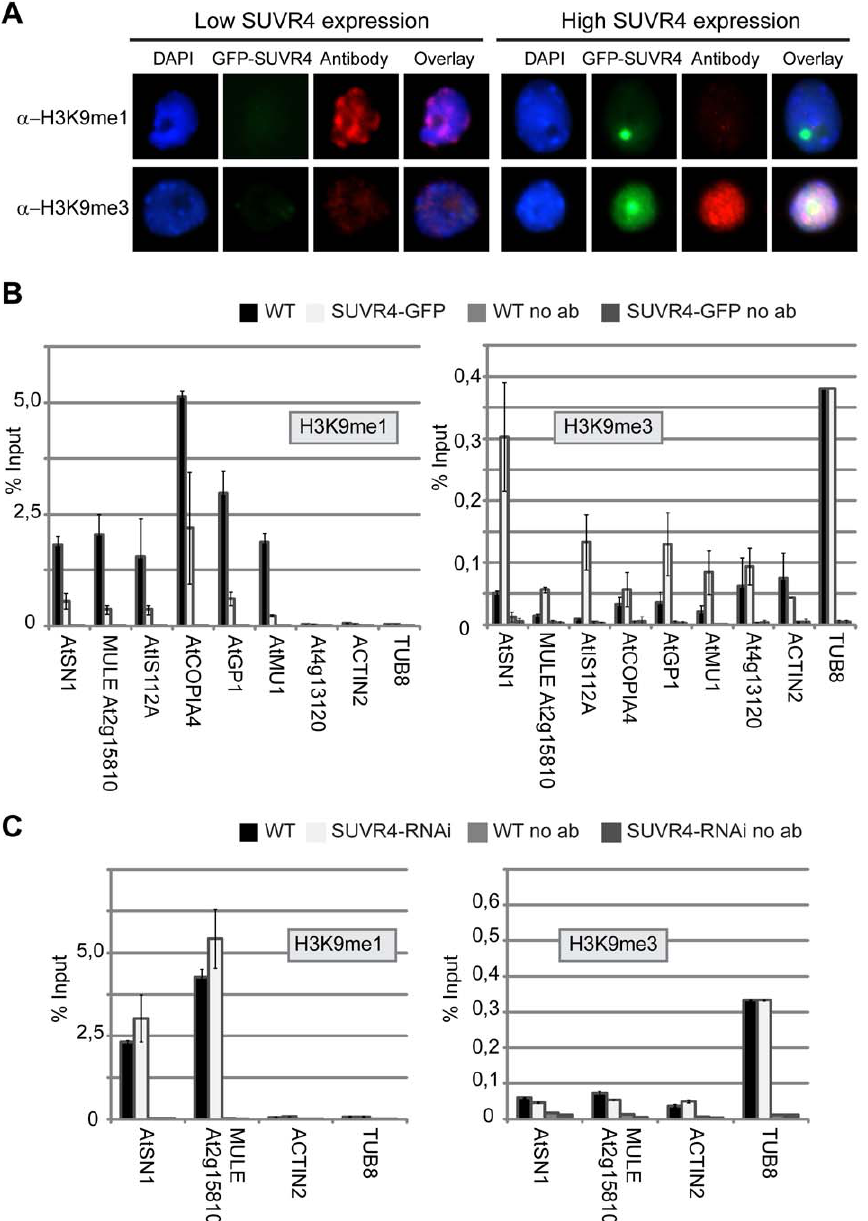
Figure 3. SUVR4 directs H3K9me3 on transposon and repeat sequences. (A) Immunostaining of nuclei from SUVR4-GFP OE seedlings with low expression (left panel) or high expression (right panel) of SUVR4-GFP with antibodies against H3K9me1 or H3K9me3. ChIP analysis of (B) SUVR4- GFP OE and (C) SUVR4 RNAi lines using antibodies against H3K9me1 (left) or H3K9me3 (right). DNA levels from the ChIP experiments (B, C) relative to the input reactions were quantified using real time PCR and normalized to TUB8 . The bars represent the average of two independent biological replicates. doi:10.1371/journal.pgen.1001325.g003 performed on two of the transposons that are targets of SUVR4 histone lysine methylation. We did not detect an effect of SUVR4 activity on DNA methylation of the MULE At2g15810 transposon for CG, CHG or CHH in neither SUVR4 OE nor SUVR4 RNAi lines (Figure 5B). This suggests that the repressive effect of H3K9me3 added by SUVR4 is not mediated by DNA methylation. In contrast, the AtSN1 transposon showed an increase in CHH methylation (Figure 5C) in the OE line. The CG and CHG methylation levels were unaffected. There was, however, no corresponding reduction of CHH methylation in the RNAi-line.